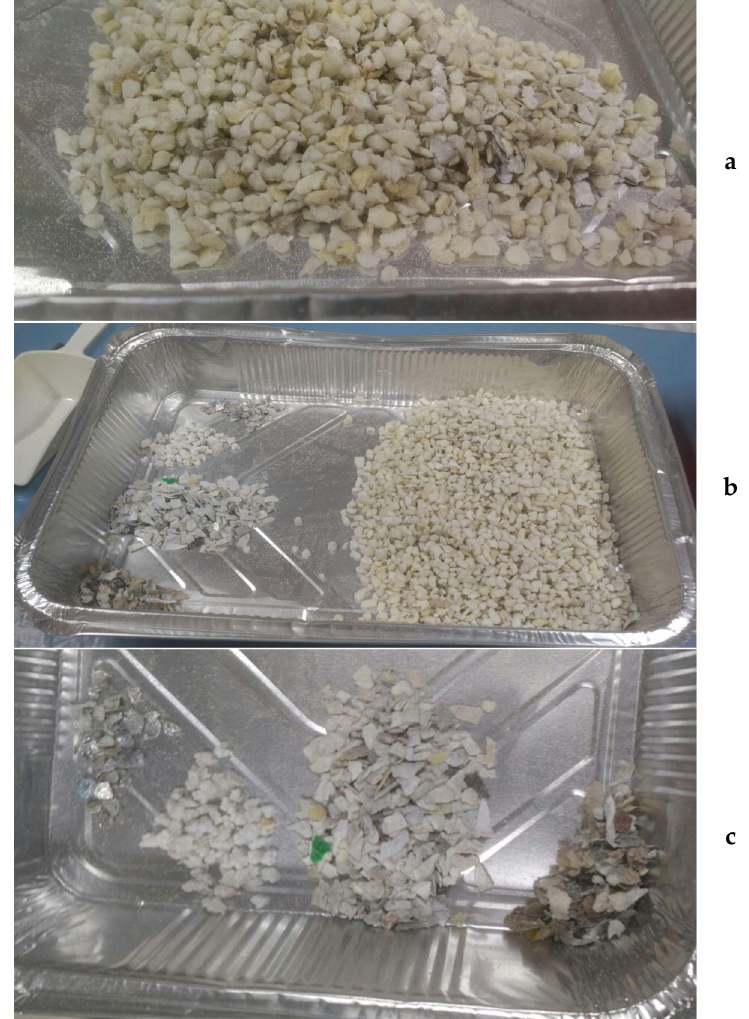
Figure 1 . Appearance of the waste polyurethane (PUF) foam: ( a ) PUF sample collected at the milling unit; ( b ) PUF sample after the removal of impurities; ( c ) impurities separated by type. Table 1. Features of different types of samples used in oil sorption tests.